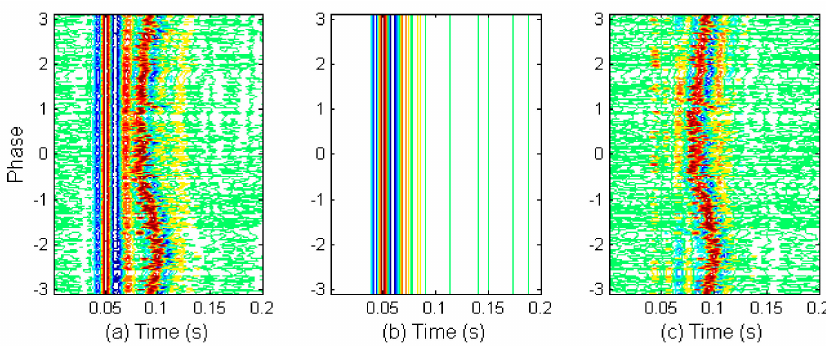
Figure 8. Example of discrimination aortic and pulmonary components for subject No. 4. ( a ) the collection of S2s shown in joint domains, ( b ) separated aortic components, ( c )